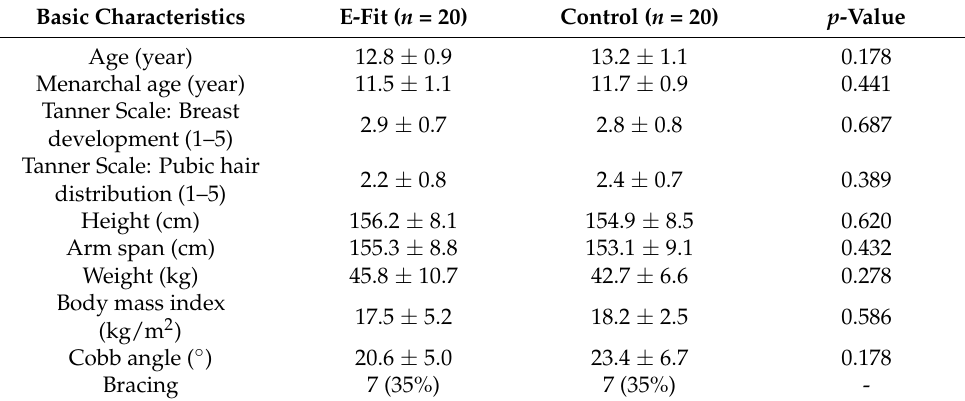
Figure 1. Flow chart of the study design. Table 1. Basic characteristics of the E-Fit and control group at baseline.